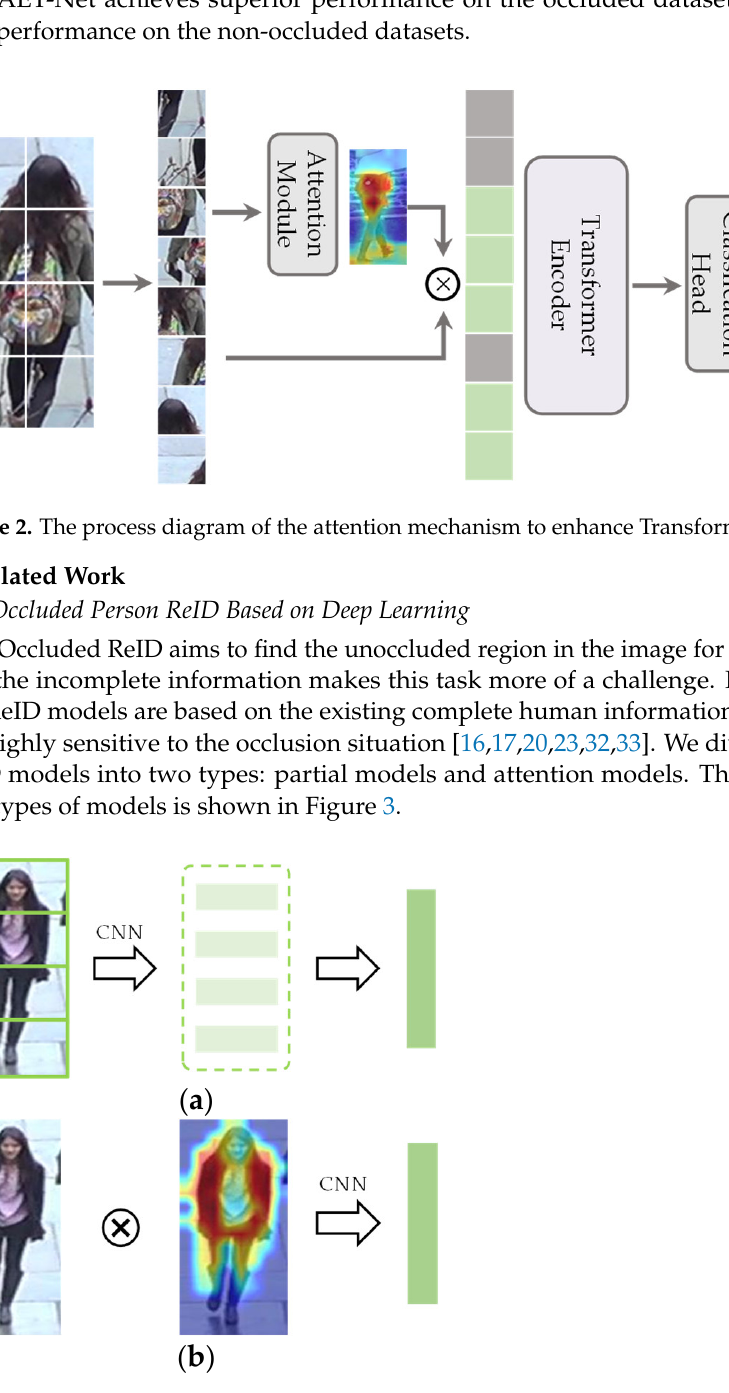
Figure 3. The process of the two types of ReID models. ( a ) partial models’ process; ( b ) attention models’ process.